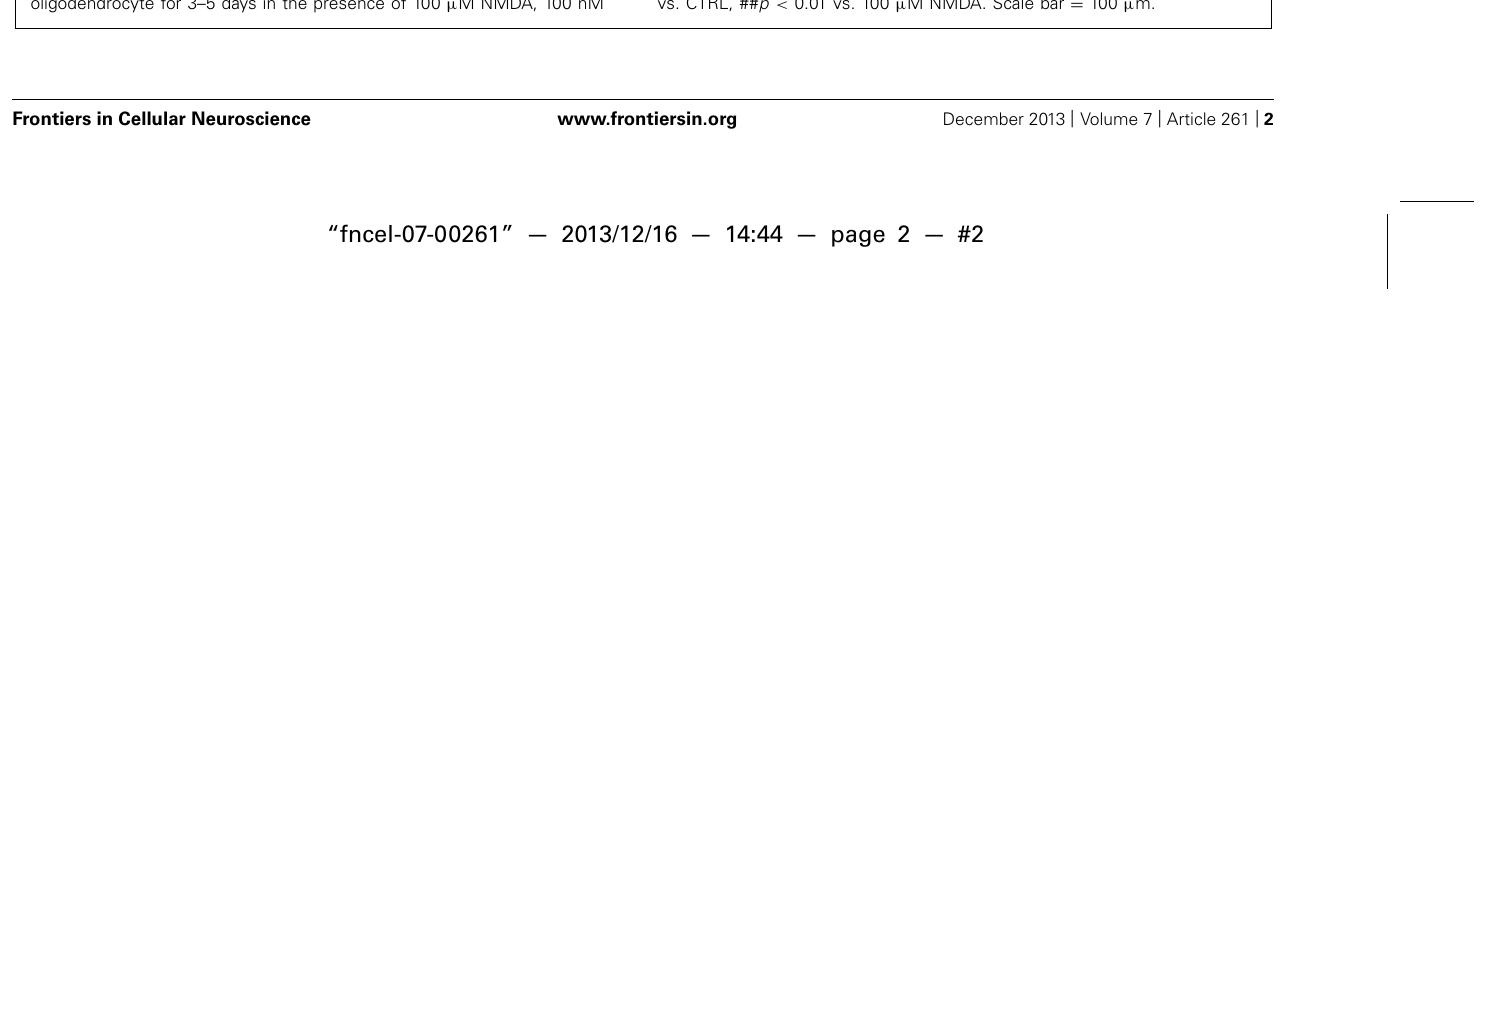
G0 6983, or 10 nM PMA. Cells were fixed, immunostained with anti-MBP (red) and counterstained with DAPI (blue; left panel). Differentiation was evaluated as the ratio between MBP positive cells vs. total cells counterstained with DAPI and expressed as a fold increase respect to the control (bar graph). Counts represent means ± SEM ( n = 4 independent experiments, five fields in each). *** p < 0.001, ** p < 0.01 and * p < 0.005 vs. CTRL, ## p < 0.01 vs. 100 μ M NMDA. Scale bar = 100 μ